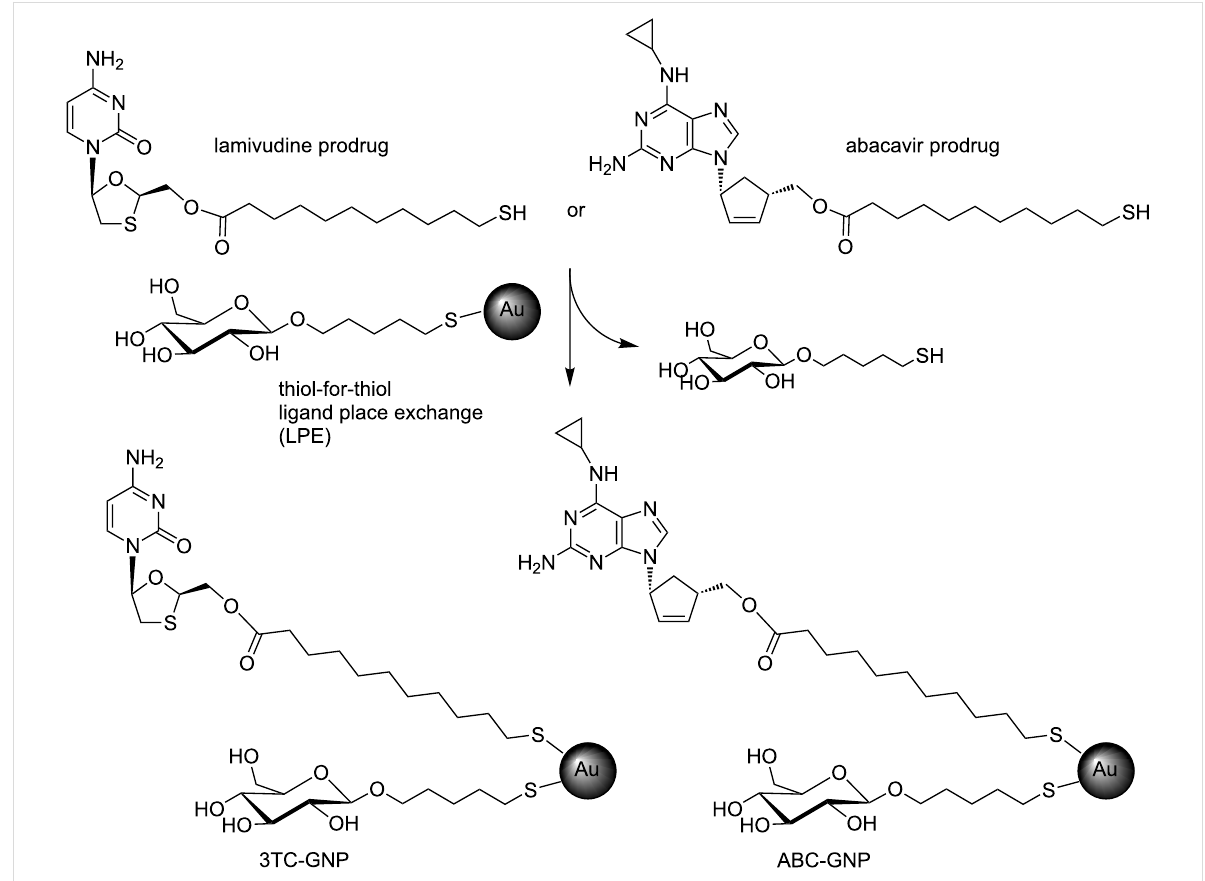
Figure 1: The prepared lamivudine (3TC) and abacavir (ABC) potential prodrugs and the corresponding 3TC- and ABC-GNPs prepared by ligand place exchange (LPE) reactions. Glucose-GNPs were incubated for 22 h with 0.1 equiv of ABC or 3TC thiol-ending drug derivatives. The reaction conditions allowed the “thiol-for-thiol” ligand exchange on the gold surface by replacing some glucose ligands on the glucose-GNPs with the prodrug